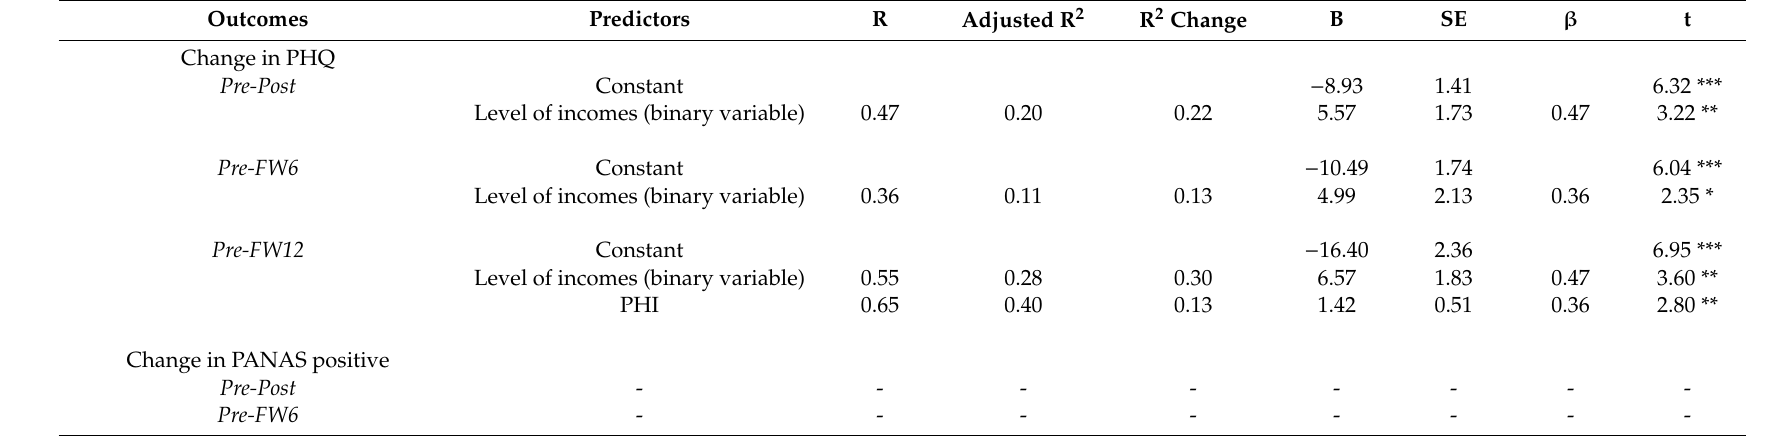
Table 5. Models for sociodemographic variables and pre-treatment scores as predictors of change in primary and secondary